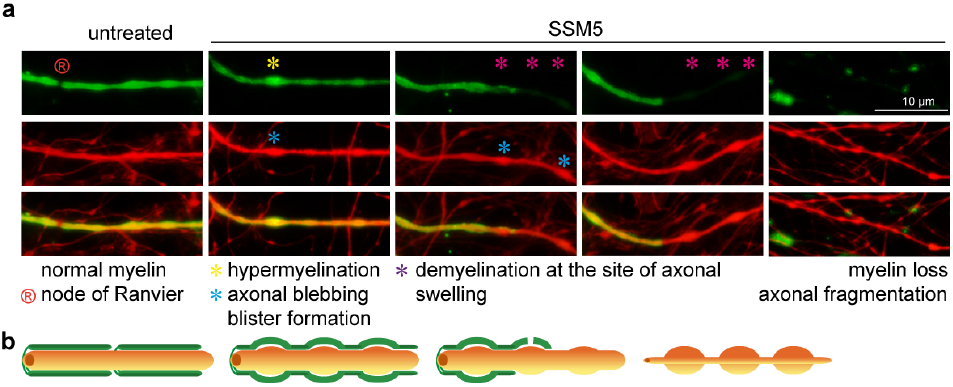
Figure 5. Treatment with SSM5 leads to axonal degeneration and demyelination. ( a ) Representative images of non-treated control (left panels), vs. cultures treated for one week with SSM5 (middle and right panels) and immunostained for NF200 (red) and MBP (green). Asterisks mark hyperintense myelin (yellow), axonal swelling (blue), demyelinated area (purple) on affected axons. Node of Ranvier marked with ® . Scale bar: 10 μ m. ( b ) schematic representation of the different types of swelling analyzed on myelinated axons (corresponding to image panels above). Proposed sequence of events: normal myelinated axon with node of Ranvier (left panel), formation of axonal bleb coincides with myelin hyperintensity that may refer to a blister-like structure (middle panels). Deterioration of myelin sheath occurs at the site of axonal injury, while axonal blebbing is further increased on demyelinating axons (right